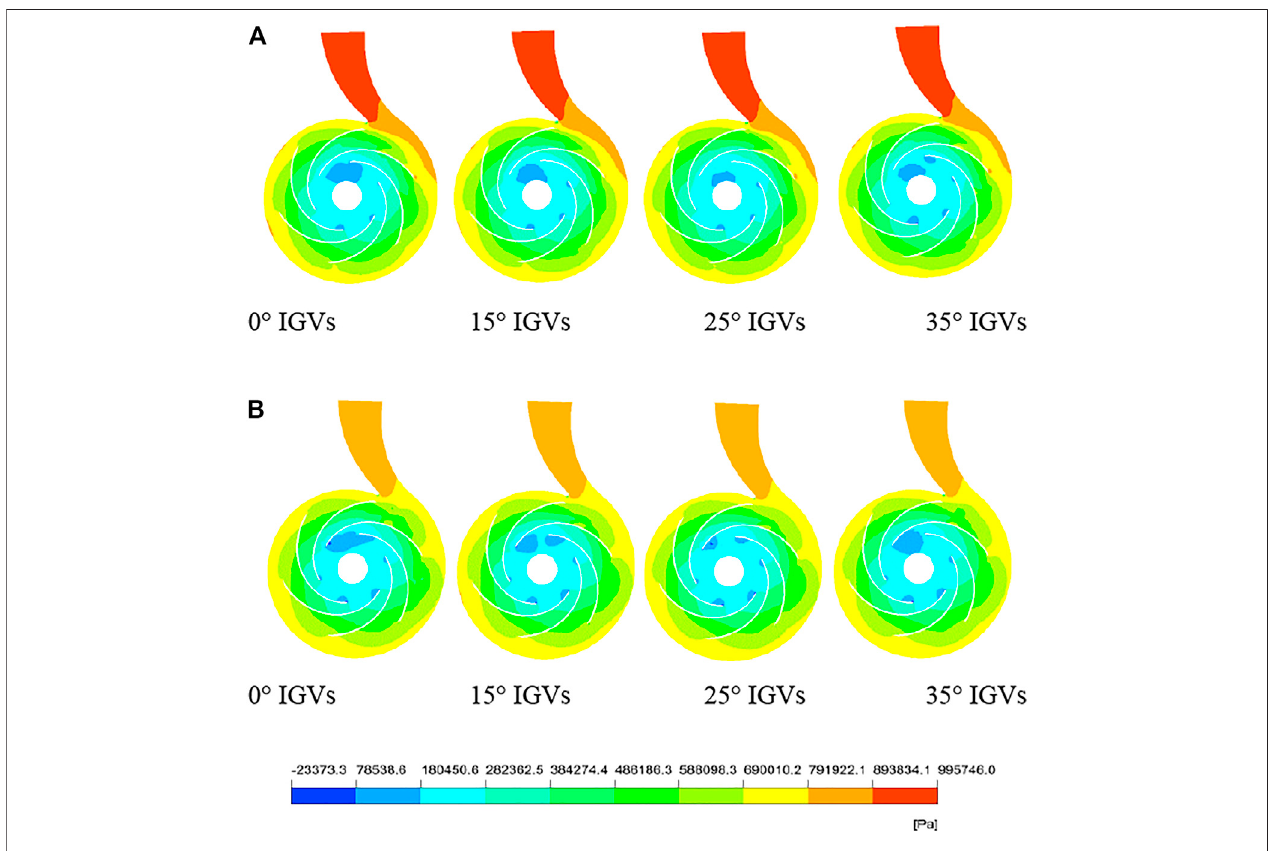
FIGURE 13 | Contours of static pressure at the cross-section: (A) 0.6 Q d and (B) 0.8 Q d .